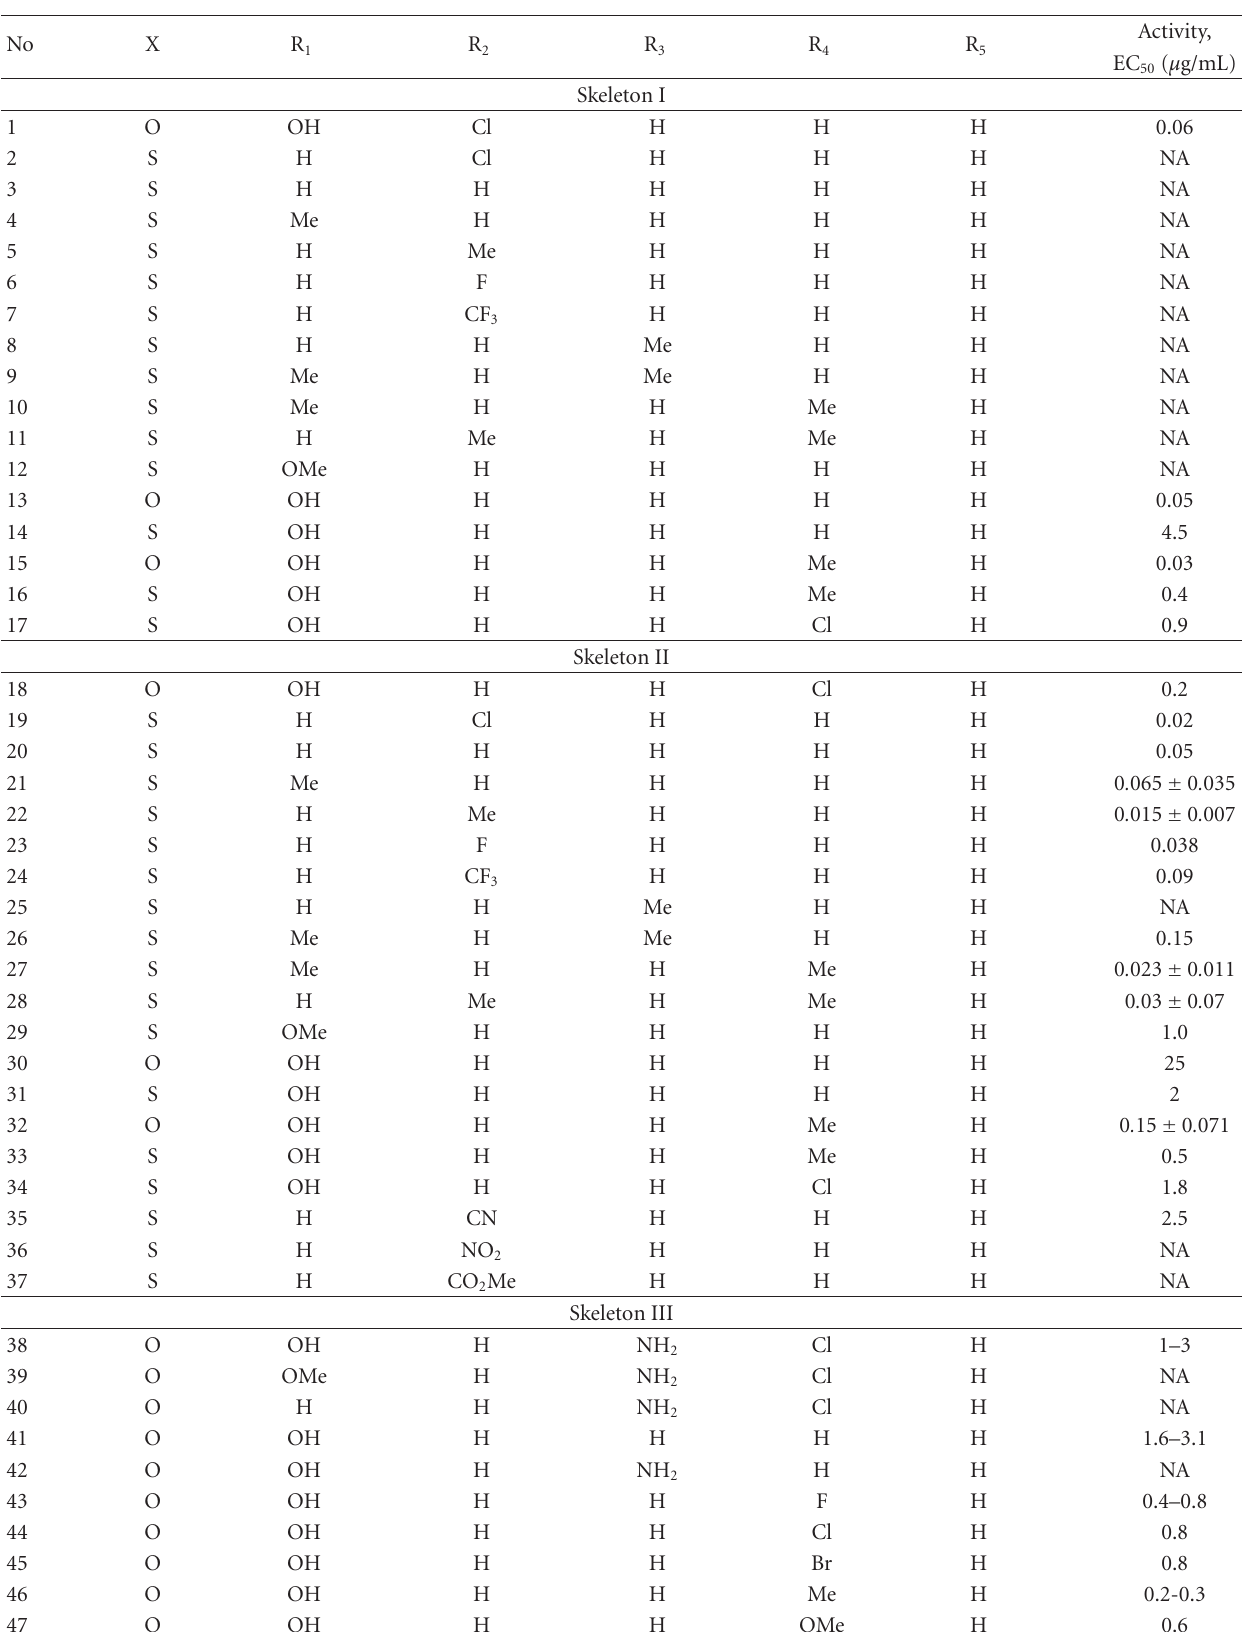
Table 1: A list of chemical molecules under